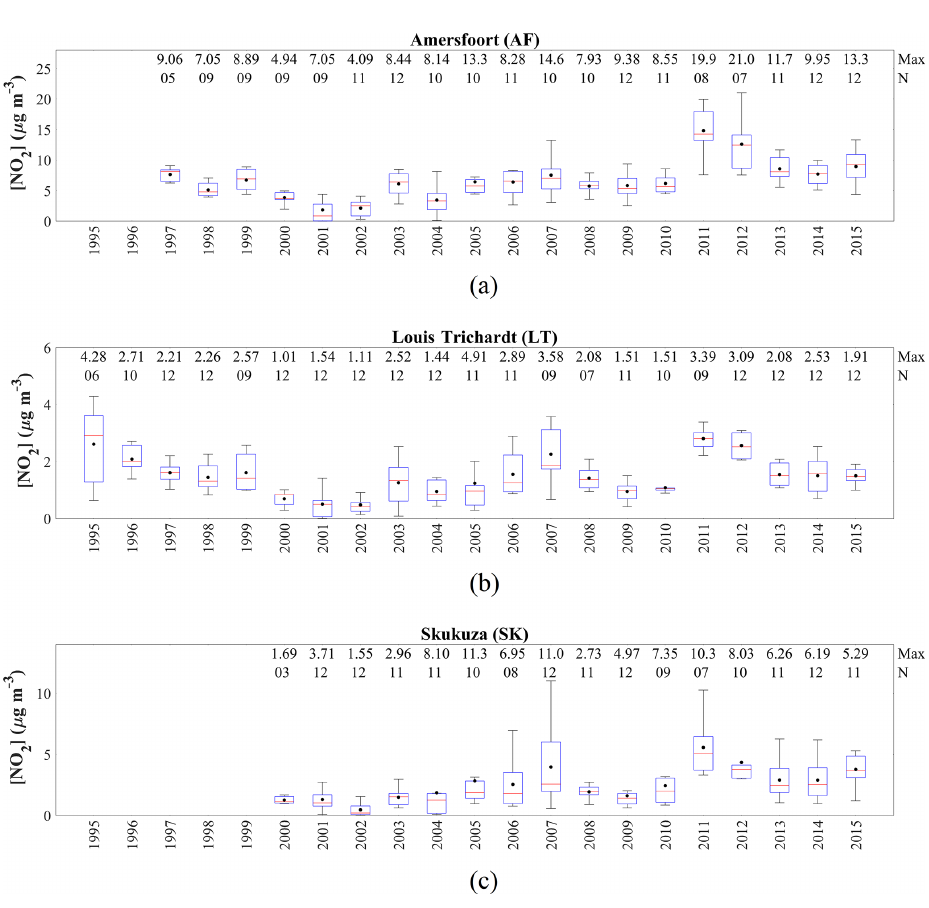
Figure 7. Annual NO 2 concentrations at (a) AF, (b) LT and (c) SK. The red line of each box represents the median; the top and bottom edges of the box represent the 25th and 75th percentiles, respectively; the whiskers are ± 2 . 7 σ (99.3% coverage if the data have a normal distribution); and the black dots represent the averages. The maximum concentrations and the number of measurements ( N ) are presented at the